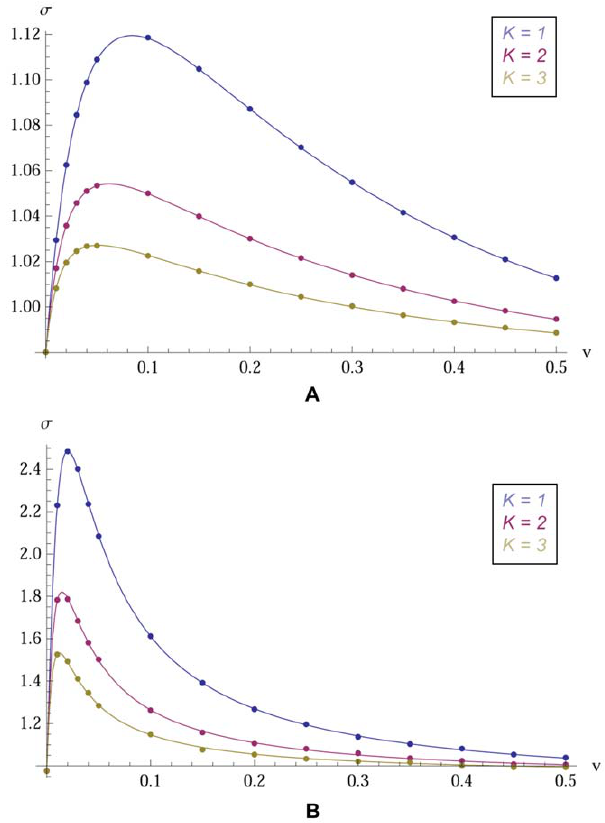
Figure 2. Agreement of simulations with analytic results. We test our simulation procedure against the analytic results of the set model of [40]. Parameters used are N ~ 100 and M ~ 10 . K ~ 1,2 or 3 is the number of sets an individual is in, u is the strategy mutation, and v is the set mutation. We run simulations for 10 7 generations. We use a low strategy mutation ( u ~ 0 : 2) in (A) and a high strategy mutation ( u ~ 0 : 002) in (B).